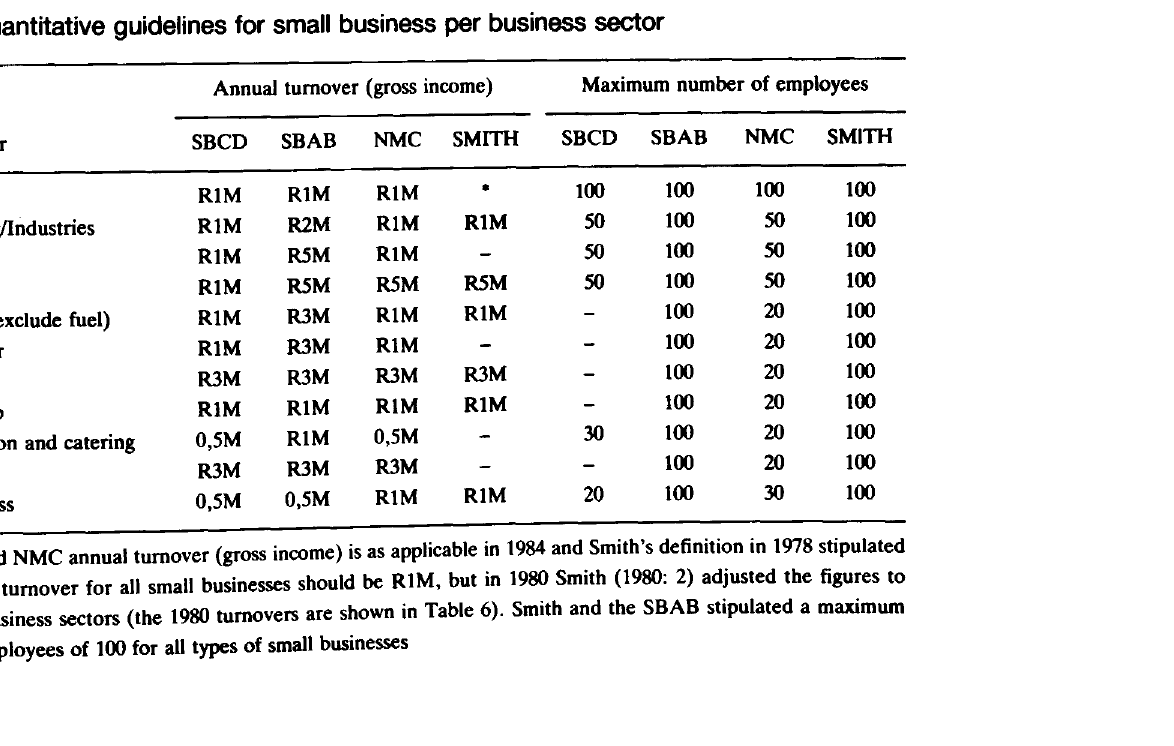
Table 6 Quantitative guidelines for small business per business